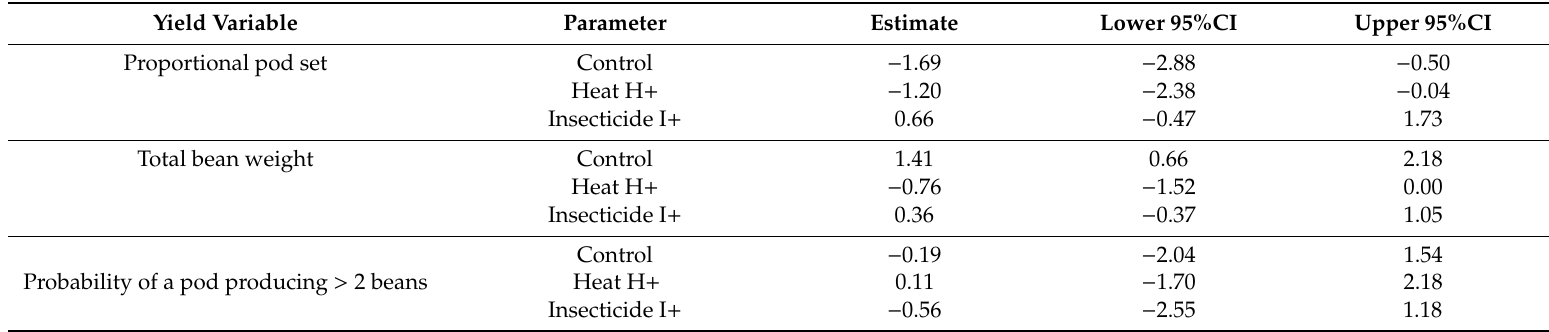
Table 6. Parameter estimates for the main e ff ects Heat (H- and H + ) and Insecticide (I- and I + ) on the yield variables analysed using Bayesian mixed models. The intercept represents the mean value at the H- (colonies maintained at 25 ◦ C) and I- (colonies reared on sucrose solution), and H + (colonies maintained at 31 ◦ C) and I + (colonies reared on sucrose containing 5 ng g -1 w / w of clothianidin) represent the di ff erence between the intercept and these factor levels. Where the 95% credible intervals do not overlap zero is evidence for an e ff ect of that parameter on